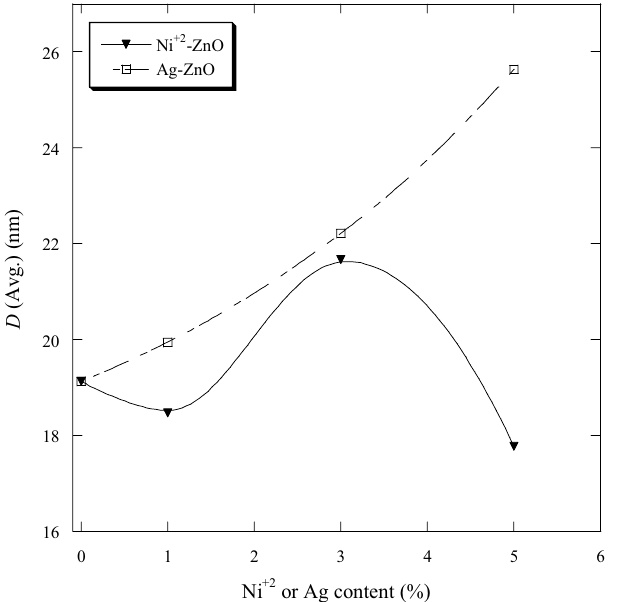
Figure 3. The average crystallite sizes of pure and ZnO doped as a function of Ni and Ag